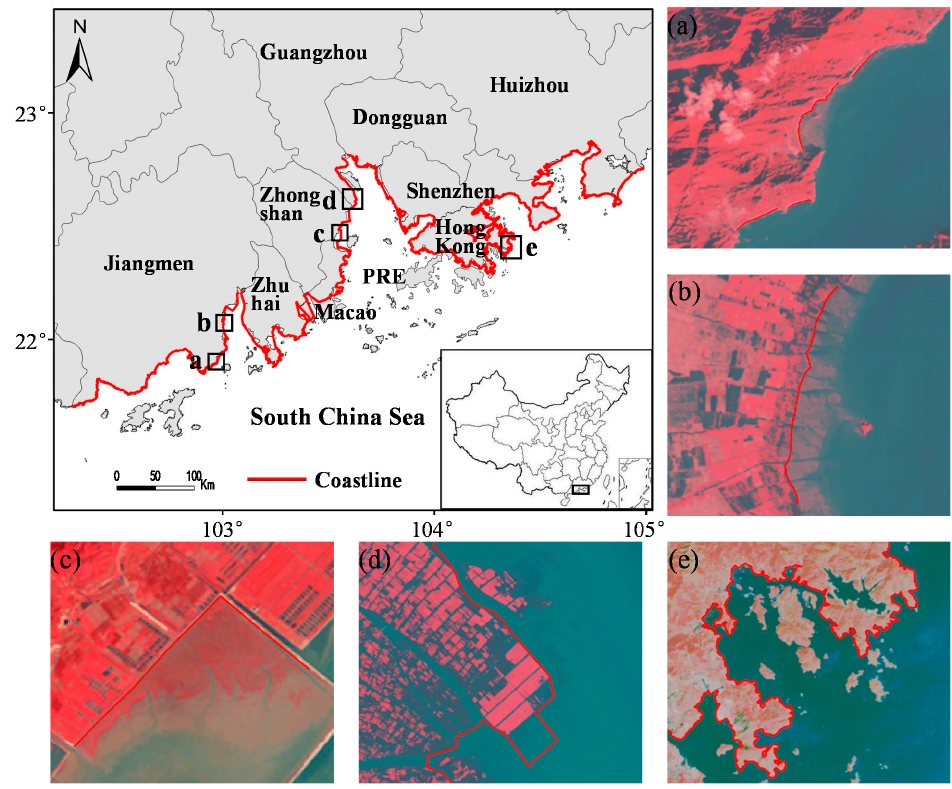
Figure 2. Map of interpretation marks of the coastline: ( a ) sandy coastline; ( b ) silty coastline; ( c ) biological coastline; ( d ) artificial coastline; and ( e ) bedrock coastline.